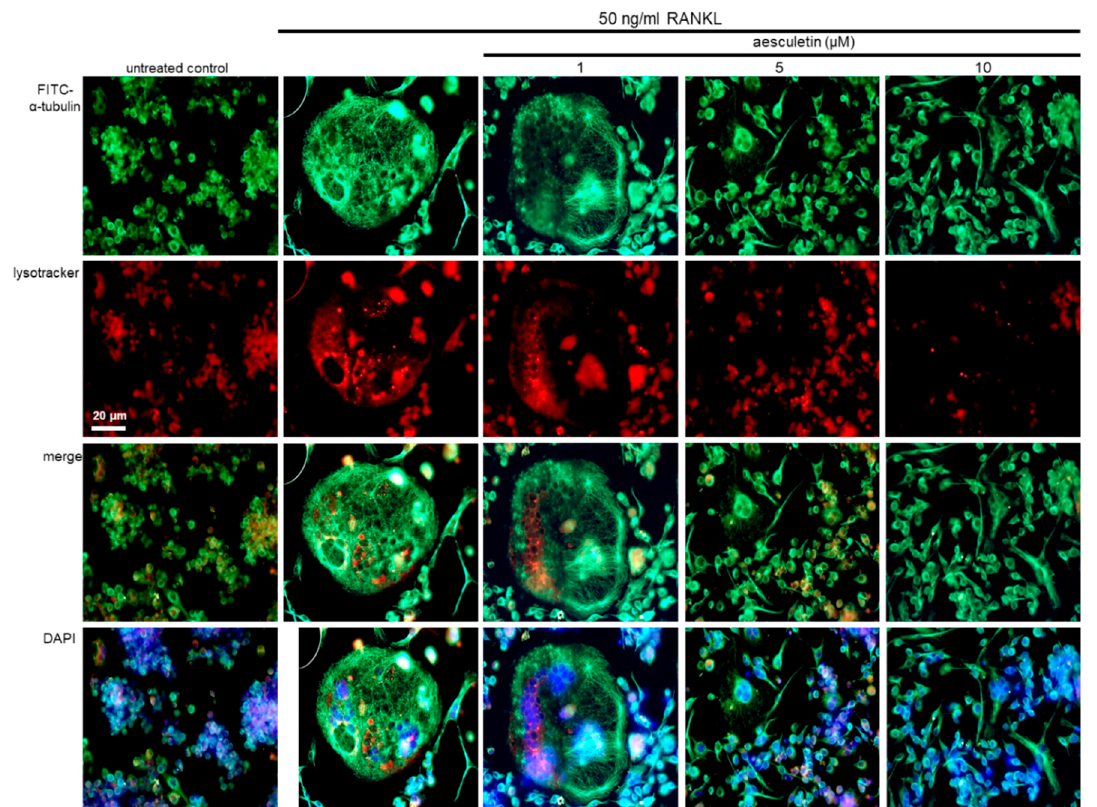
Figure 7. Blockade of positioning of lysosomes and microtubules in actin ring-bearing osteoclasts. Raw 264.7 cells were cultured for 5 days with 50 ng/mL receptor activator of nuclear factor- κ B ligand (RANKL) in the absence or presence of 1–10 μ M aesculetin. RANKL-differentiated cells were fixed in 4% paraformaldehyde for 10 min, followed by immunocytochemical analysis with a primary antibody of α -tubulin and anti-mouse IgG conjugated with fluorescein isothiocyanate (FITC). Subsequently, commercially available red fluorescent lysoTracker Red DND-99 dye was employed for the staining of lysosomes. Finally, cells were counterstained with 4 ′ ,6-diamidino-2-phenylindole (DAPI) for nuclei. Representative fluorescent images were obtained with a fluorescence microscope ( n = 3). Scale bar = 20 μ m.